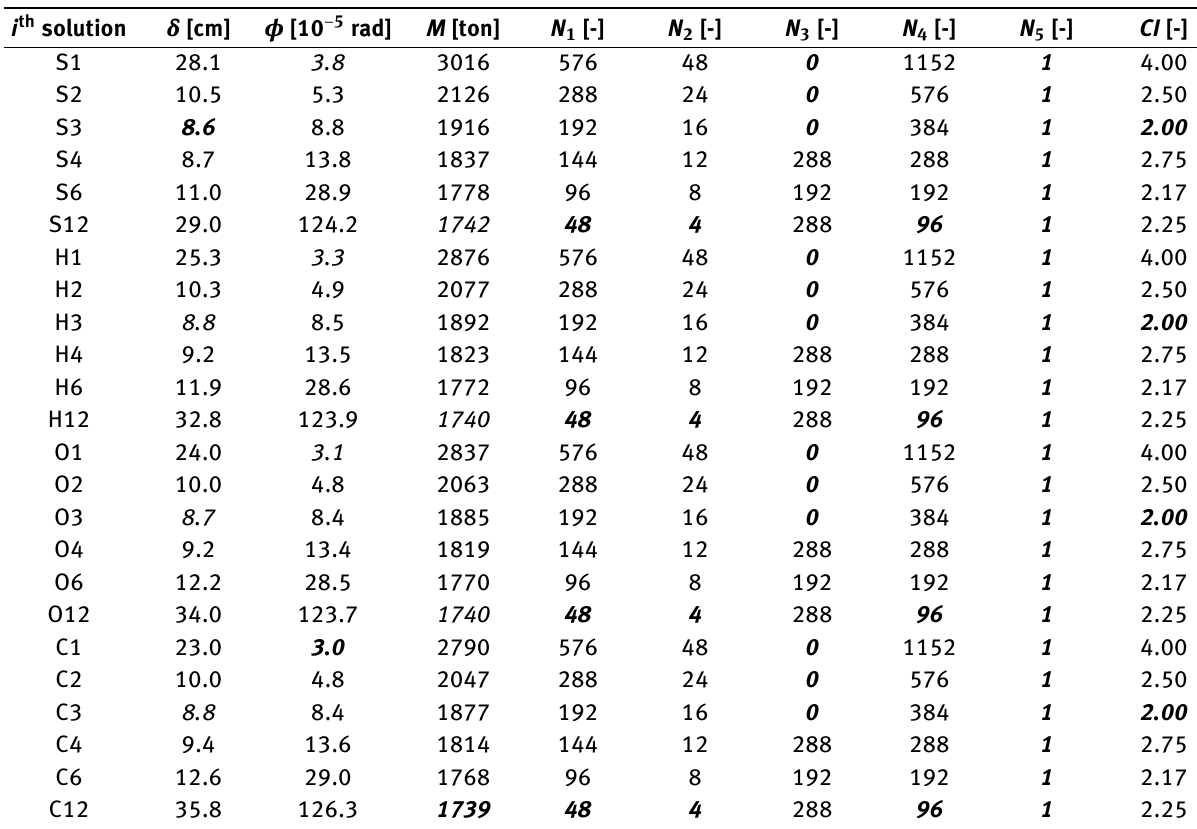
Table 2: Response variables ( δ , ϕ , M , CI ) for the twenty-four diagrid geometries (minimum values for each floor shape are in italic , absolute minimum values are in bold italic